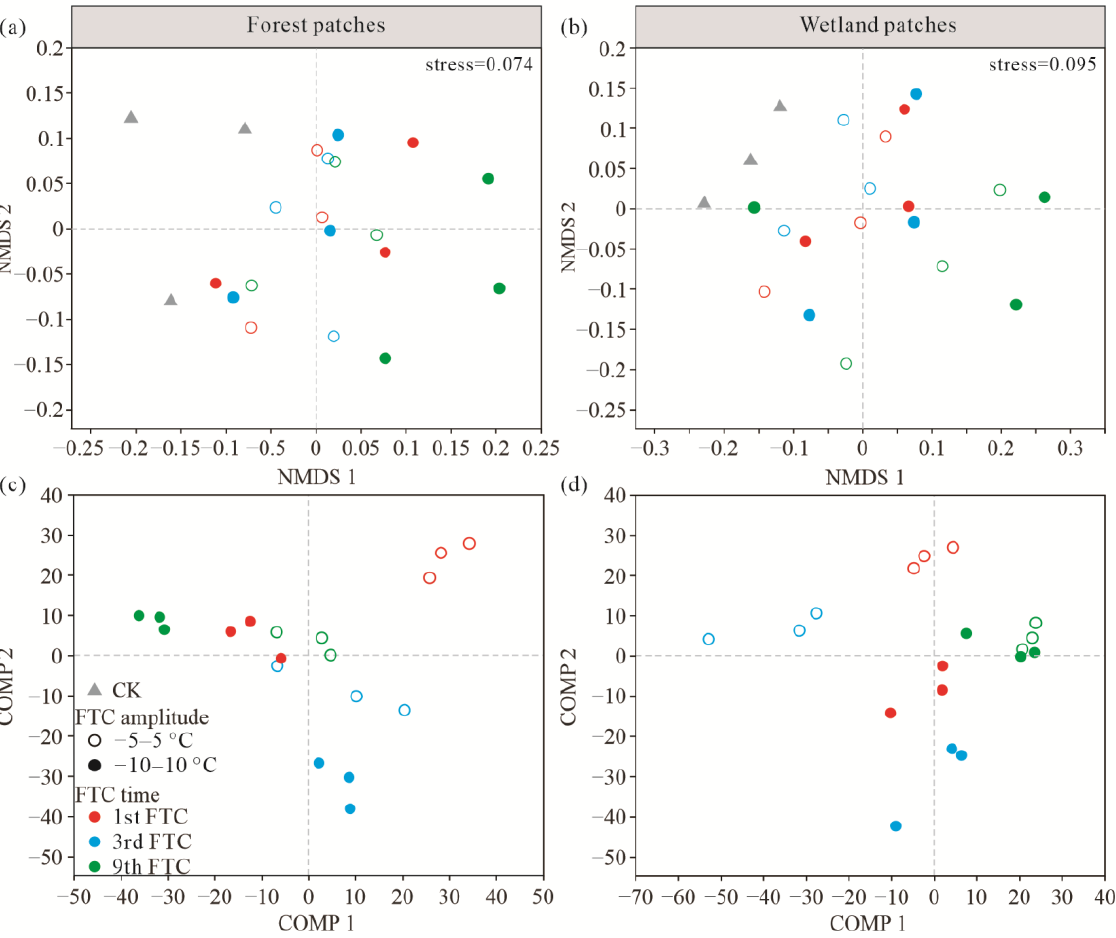
Figure 6. NMDS ( a , b ) and PLS-DA plots ( c , d ) revealing the effects of FTCs on the bacterial community. Hollow circles and solid circles indicate different FTC amplitudes. Hollow circles indicate FTCs at − 5 – 5 °C; solid circles indicate FTCs at − 10 – 10 °C.